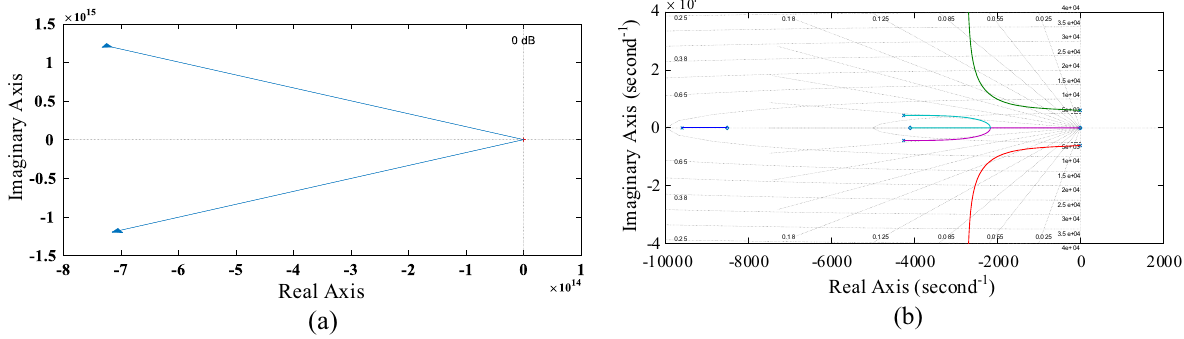
Fig. 4 a Nyquist and b root‑locus plot for single‑phase MG system